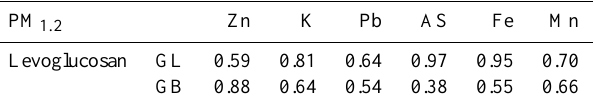
Table 2. Correlation coefficients ( r 2 ) between levoglucosan and Zn, K, Pb, Fe, and As before (GL) and after (GB) air mass parcel passed through the cloud with p values less than